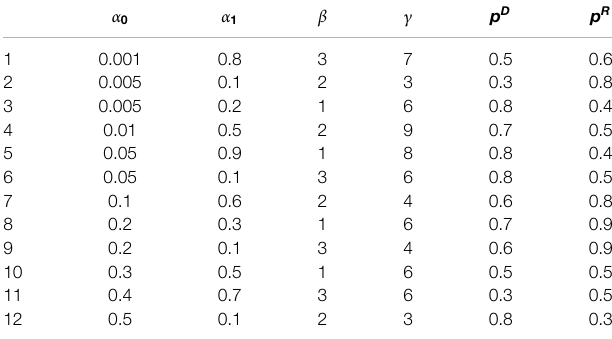
TABLE 1 | The parameters of ILM generating